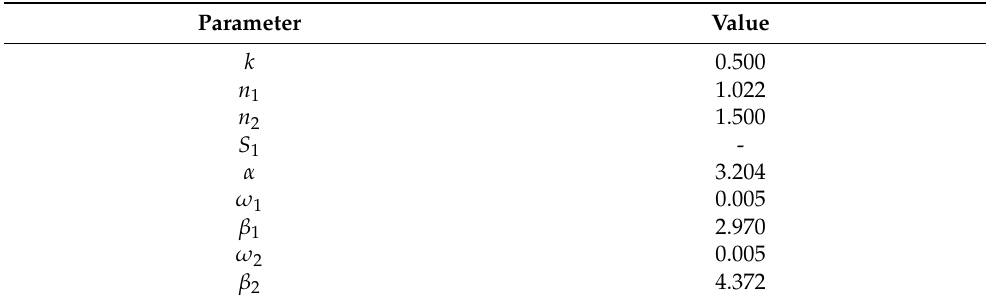
Table 6. Parameters of the mathematical approach to predict particle size distribution. All parameters are dimensionless. Parameter